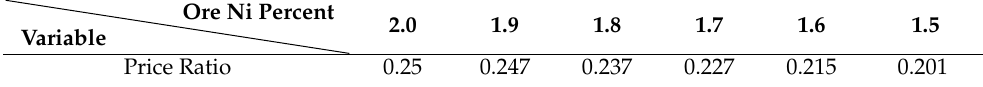
Table 1. Model 2 (cid:48) s fluctuating price ratios per change in Ni content. Variable